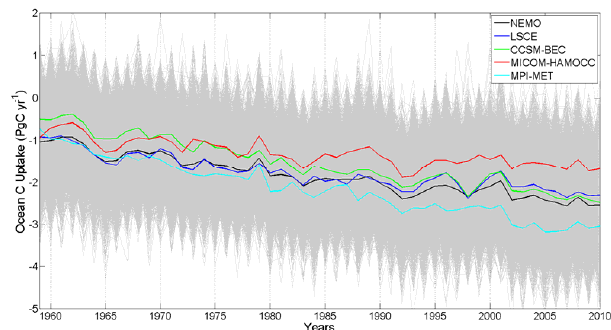
Figure 6. Ocean carbon uptake estimates from five different ocean biogeochemical models. Independent time-invariant random error of 1.3PgC (2 σ ) has been added to each annual model simulation according to independent estimates of ocean C uptake (Ishidoya et al., 2012). For each biogeochemical model estimate, 900 Monte Carlo simulations were performed to better estimate error (thin grey